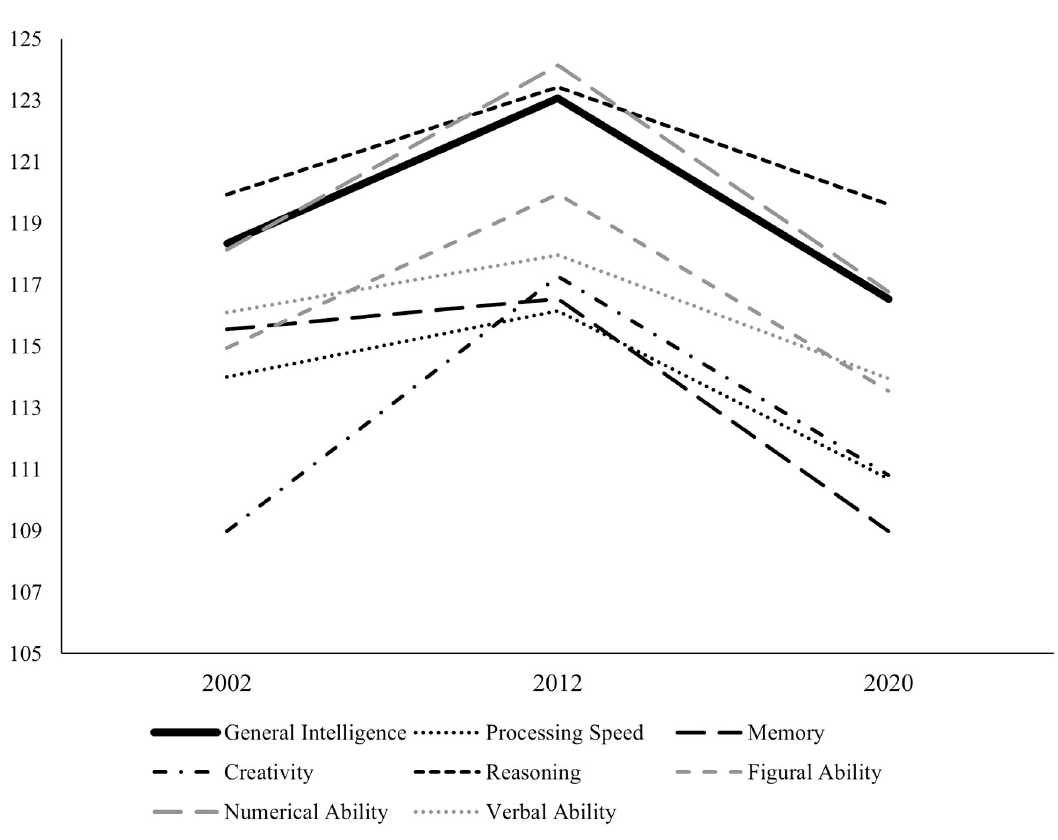
Fig 8. Mean IQs for the different ability scores in Analysis 1b.